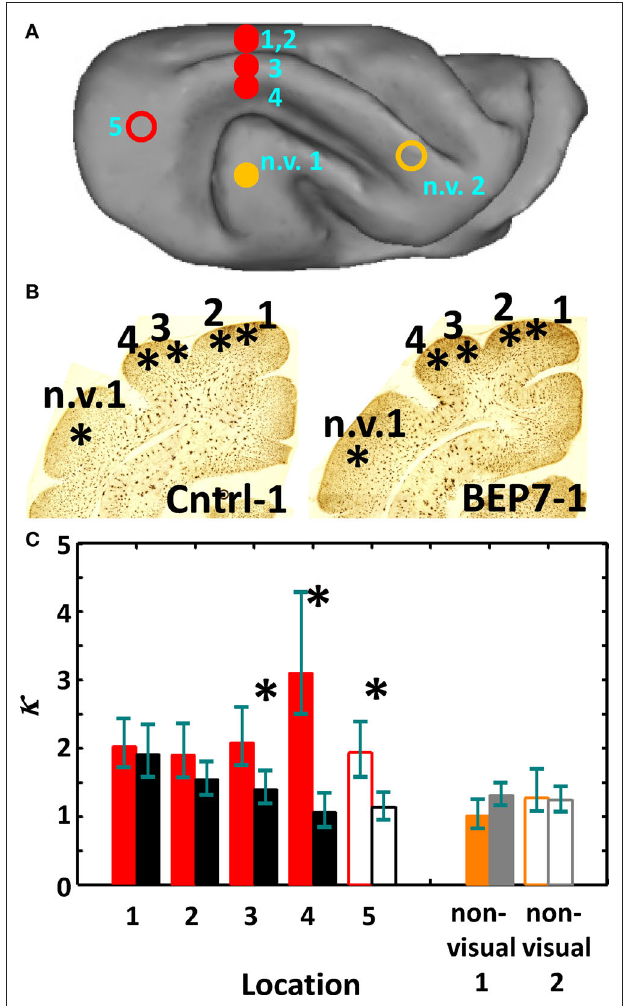
FiGure 5 | Comparison of the distributions of orientations of neuronal processes in visual and non-visual areas of BeP7 and control ferrets at P31. The value of the parameter κ decreases as the distribution of orientations broadens (less concentrated). In (A) , filled circles represent locations of regions analyzed in coronal sections of Cntrl-1 and BEP7-1, with red indicating visual cortical areas, and orange a non-visual area. Open circles represent locations of regions analyzed in axial sections of Cntrl-2 and BEP7-2, with red and orange indicating visual and non-visual areas, respectively. (B) Cortical locations 1–4 and non-visual area 1 are shown in montages of Golgi sections (C) Concentration parameters, κ , of von Mises distributions associated with the sets of neuronal process orientations are shown for case BEP7-1 (visual locations, red filled bars; non-visual location, filled orange bar) and case Cntrl-1 (visual locations, black filled bars; non-visual location, filled gray bar), and case BEP7-2 (visual location, red open bar; non-visual location, open orange bar) and case Cntrl-2 (visual location, black open bar; non-visual location, open gray bar). Error bars represent 95% confidence intervals for κ . For visual locations indicated with asterisks, 95% confidence intervals for BEP7 and control regions do not